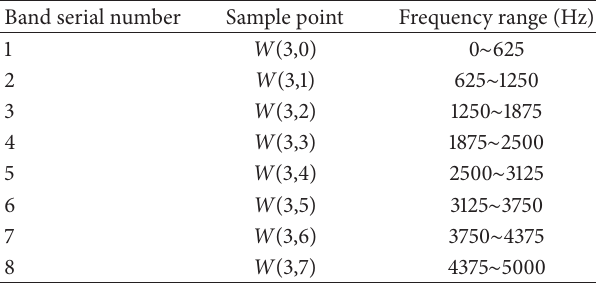
Table 1: A wavelet packet frequency band-frequency tablet. Band serial